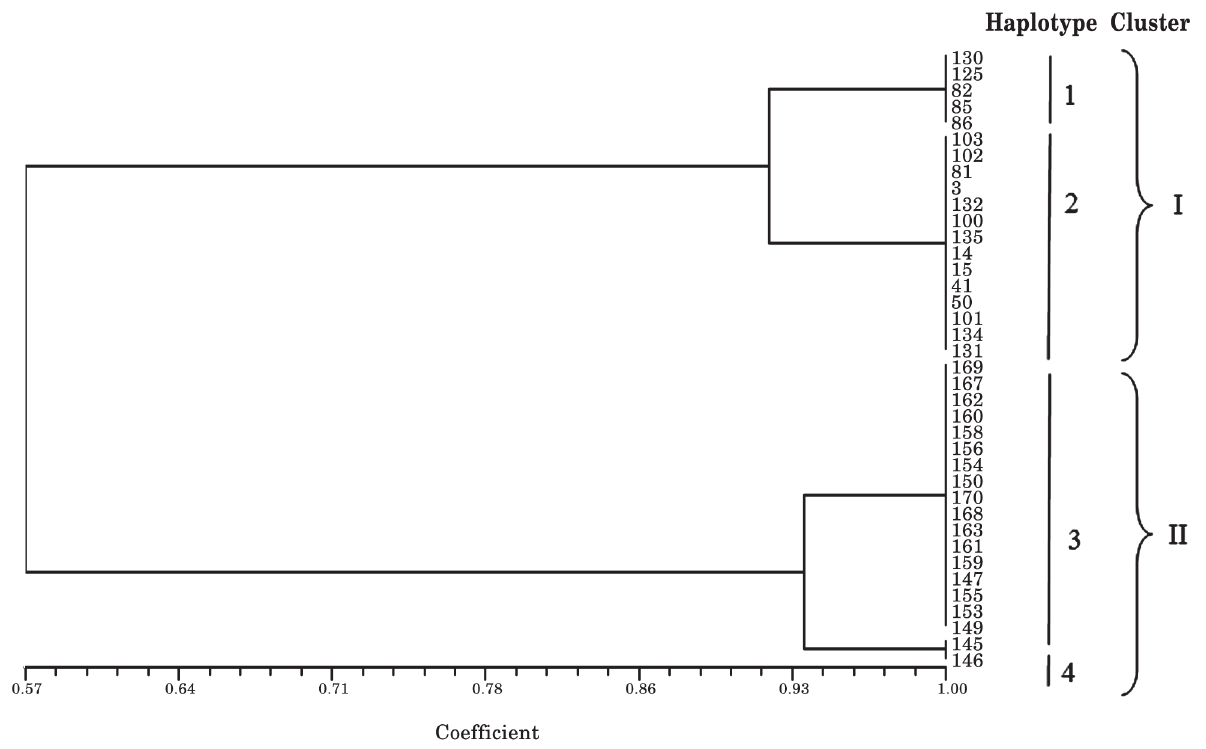
Figure 3. Dendrogram based on rep-PCR of Ralstonia solanacearum isolates with REP, ERIC and BOX